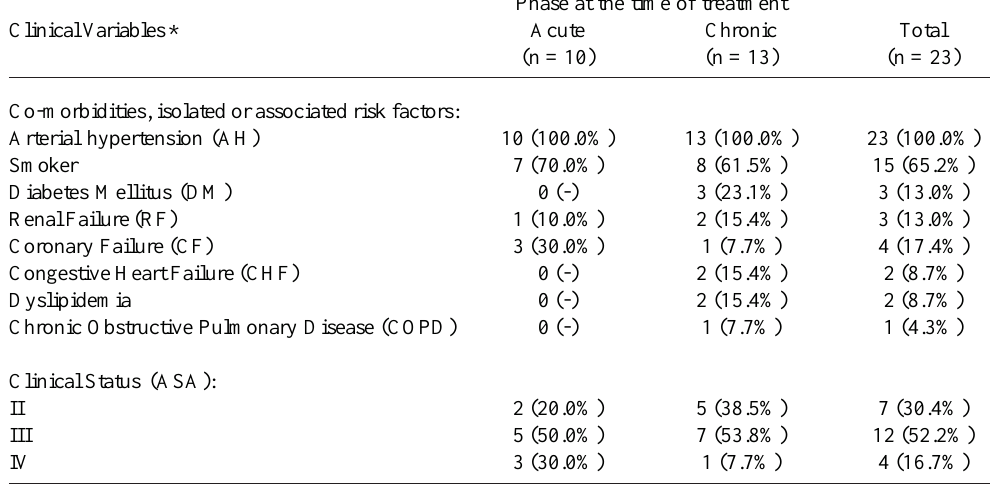
Table 3. Clinical data of the 23 patients submitted to endovascular treatment of complicated Stanford type B thoracic aortic